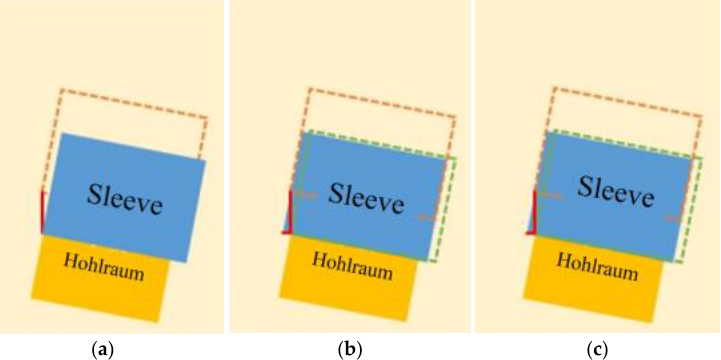
Figure 9. Schematic of the force adjustment trajectory of TMP component and hohlraum. ( a ) Force of contact in horizontal and vertical directions are lower than the safe threshold; ( b ) Contact force in horizontal direction is higher than safety threshold; ( c ) Contact force in vertical direction is lower than safe threshold.